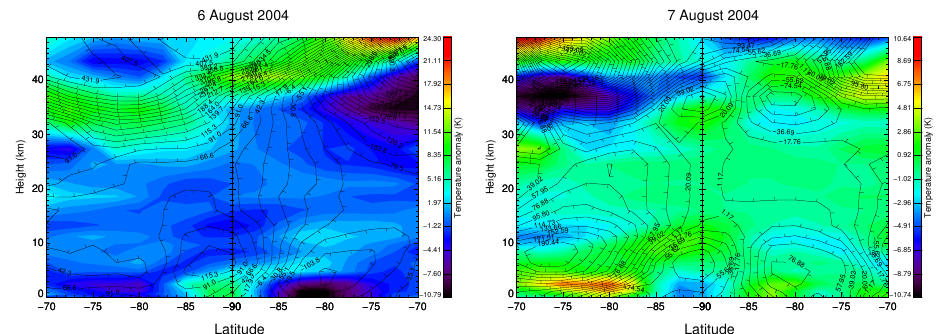
Figure 9. The 24h time-differenced contour plots of geopotential height (black contours) and temperatures obtained from ECMWF Reanal- ysis from 0 to 50km along the directions of the ray paths of the 6 August 2004 (left) and 7 August 2004 (right) waves, as determined by GROGRAT. Ticks on contour lines point to lower geopotential